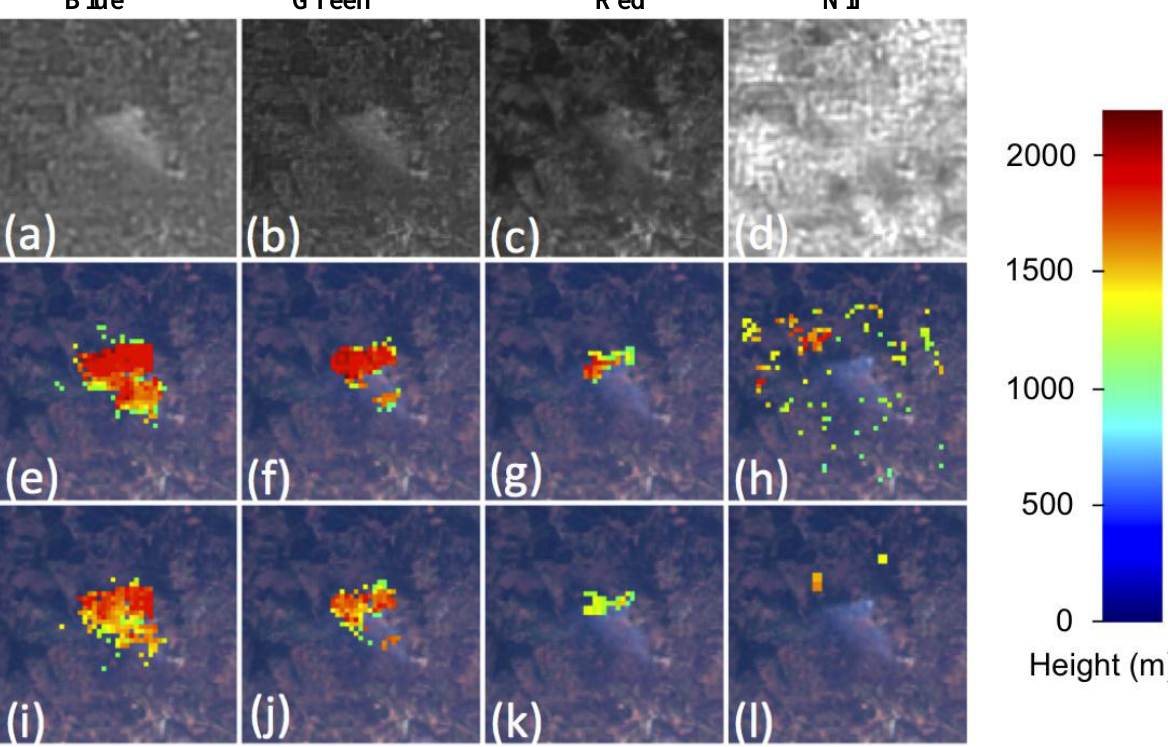
Figure 9. Single-band, global mode images and height retrieval maps for the scene in Figure 6. Aa camera global mode images for bands: ( a ) blue; ( b ) green; ( c ) red; and ( d ) NIR. Zero-wind heights for global mode data retrieved using bands: ( e ) blue; ( f ) green; ( g ) red; and ( h ) NIR. Wind-corrected heights corresponding to heights in (e–h): ( i ) blue; ( j ) green; ( k ) red; and ( l ) NIR. Blue Green Red